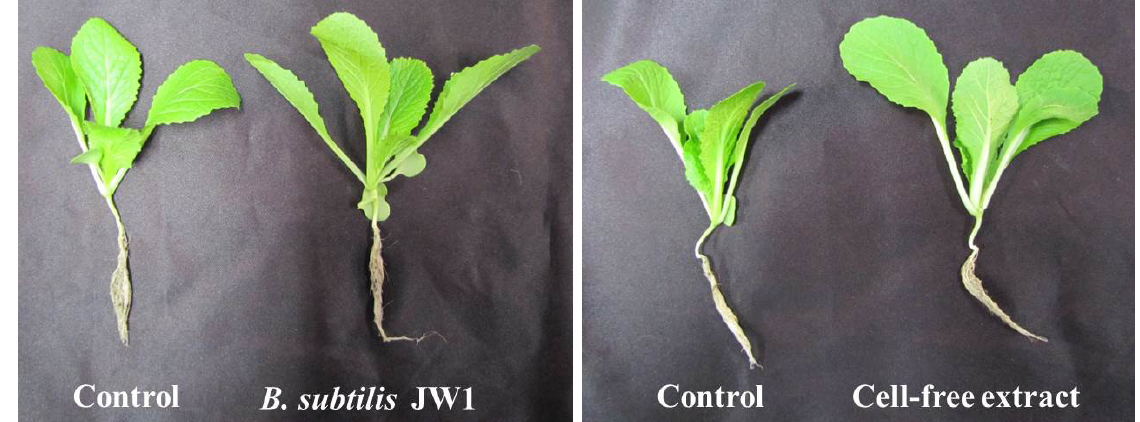
Fig. 6: Influence of B. subtilis JW1 and cell free CF on growth attributes of Chinese cabbage.